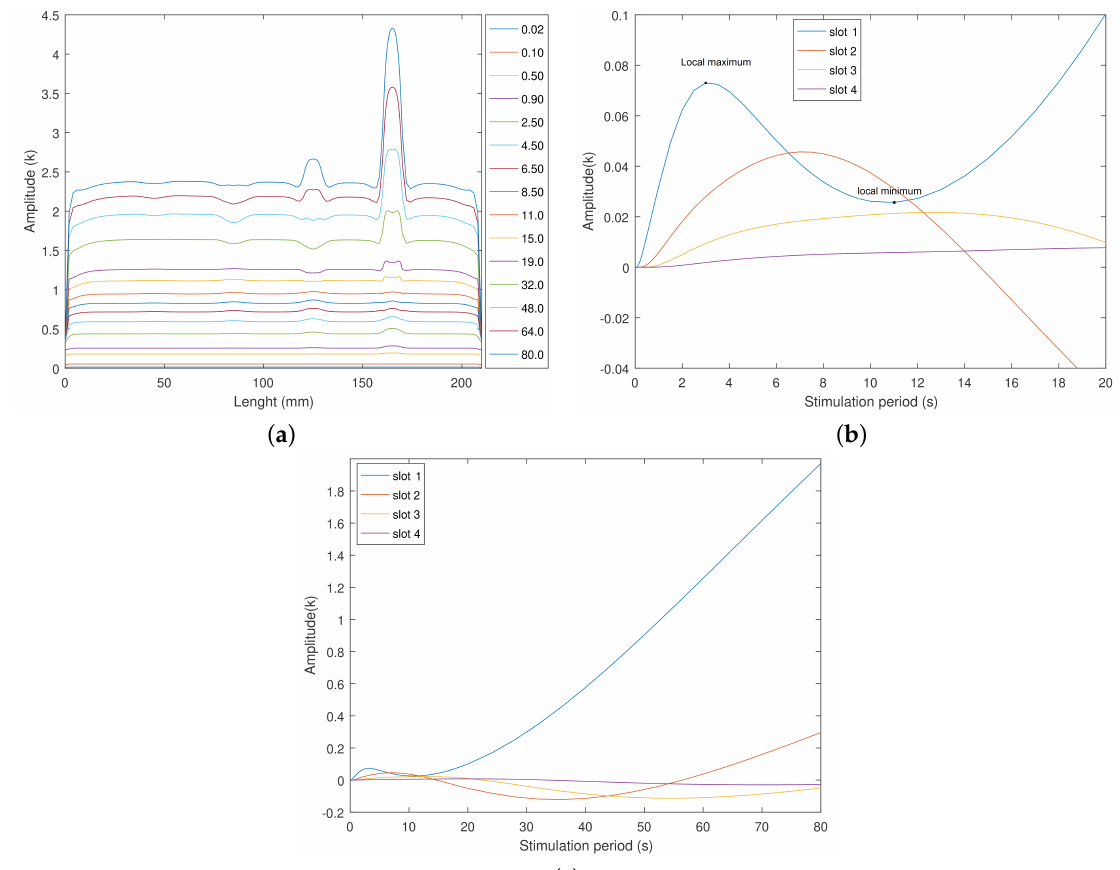
Figure 10. Amplitude response and Amplitude difference, function of the cycle period. ( a ) Amplitude responses from the stimulation surface after 15 cycles. ( b ) Amplitude difference between slots 1, 2, 3, and 4 and their sound areas, for cycle periods of 0.02 to 20 s. ( c ) Amplitude difference between the slot and its surroundings from 0.02 to 80 s per cycle.